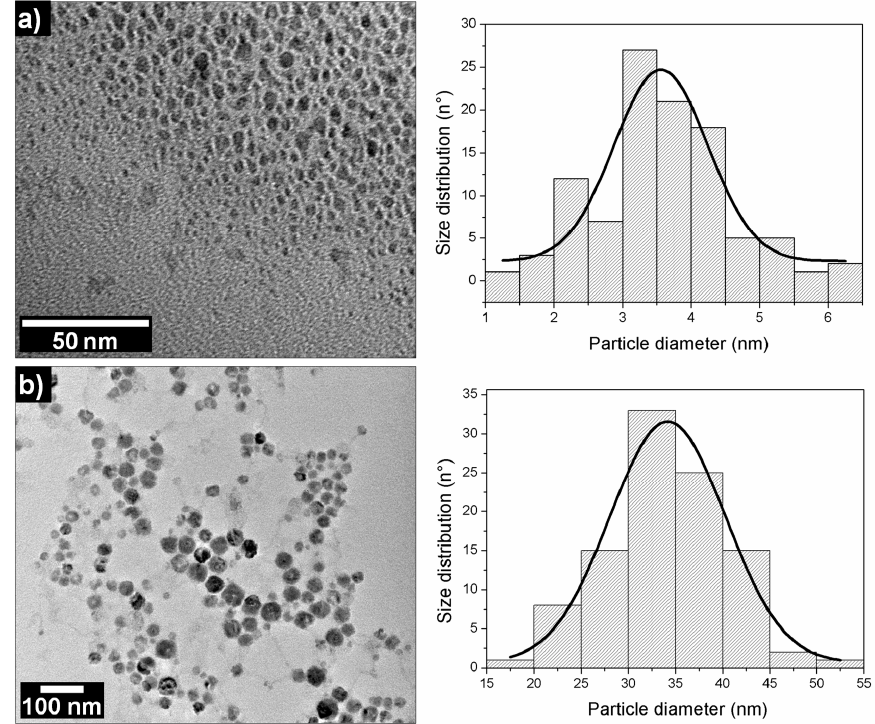
Figure 2. Transmission Electron Microscopy (TEM) micrographs of a ) copper nanoparticle (Cu